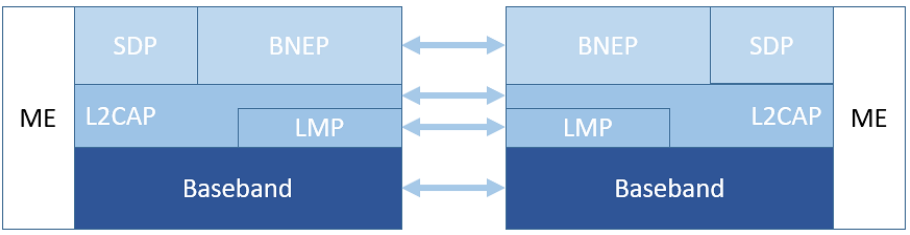
Figure 3. Bluetooth PAN Profile and the interacting protocols.